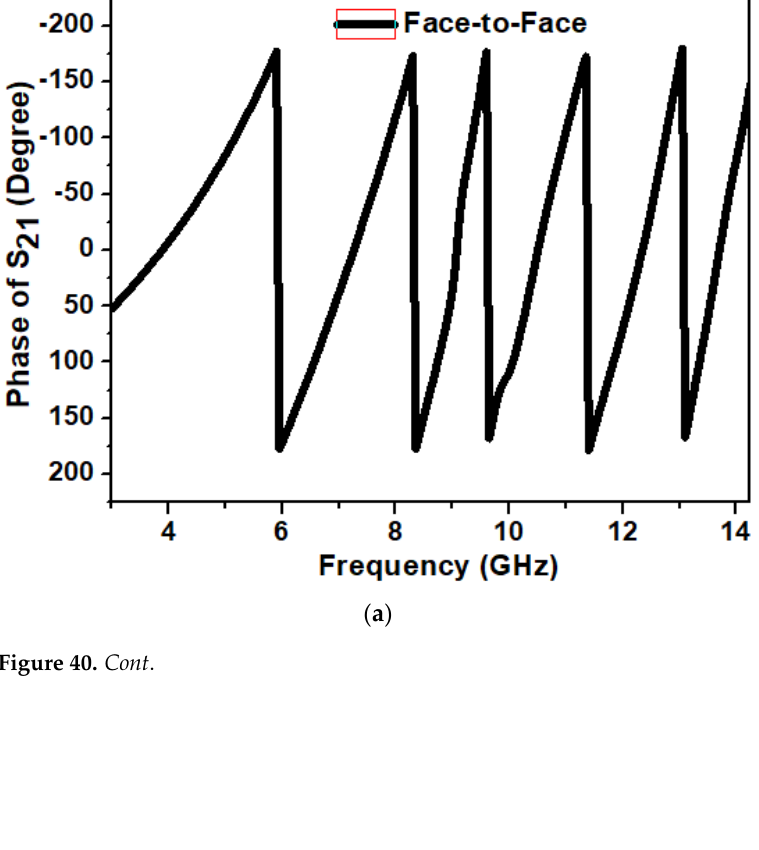
Figure 39. Isolation. The phase response is almost linear for both frontal and lateral orientations except for the notch bands, as shown in Figure 40.